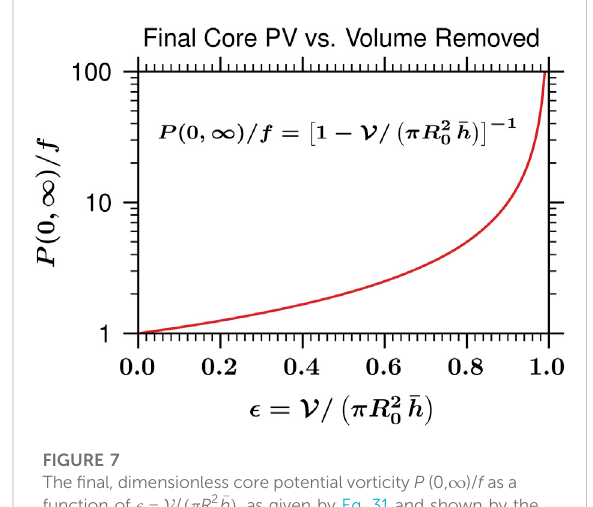
FIGURE 7 The fi nal, dimensionless core potential vorticity P (0, ∞ )/ f as a function of ϵ (cid:2) V / ( π R 2 0 (cid:1) h ) , as given by Eq. 31 and shown by the displayed formula. Note that the scale on the ordinate is logarithmic.Ifweregard R 0 asgiven,theabscissaisameasure FIGURE 8 of the total volume of fl uid removed by the mass sink. This graph Plots of P (0, τ )/ f , as given by Eq. 31 for the three choices τ s =3,6,12 h, and for the three choices R implies that it is the removal of the last 10% of the initial volume of 0 =200,300,400 km. The f tomorethan fl uidinside R time evolution of P (0, τ )/ f is plotted for 0 ≤ τ ≤ 72 h, and the volume 0 thatcanrapidlyspinupthePVfrom10 100 f . Since P (cid:2) ( f + ζ )( (cid:1) h / h ) , large values of P are associated with parameter is chosen to be V (cid:2) 3 . 174 × 10 13 m 3 . This speci fi ed large values of the absolute vorticity ( f + ζ ) and small values of the value of V is 99.0% of the initial volume inside the potential radius fl uid depth h . R 0 =200 km, 44.0% of the initial volume inside the potential radius